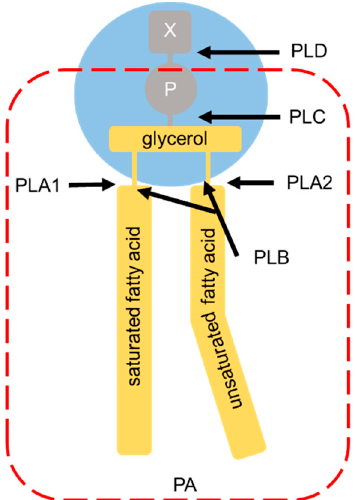
Figure 4. Phospholipase hydrolysis sites. Phospholipase classification is based on their specific sites of phospholipase-mediated hydrolysis. The head groups of the glycerophospholipids are bound to the glycerol moiety at the sn -3 position. X: choline (for phosphatidylcholine), ethanolamine (for phosphatidylethanolamine), serine (for phosphatidylserine), or myo-inositol (for phosphatidylinositol); P: phosphate group; PLD: phospholipase D; PLC: phospholipase C; PLA1: phospholipase A1; PLA2: phospholipase A2; PLB: phospholipase B. The arrows indicate the sites of hydrolysis by each phospholipase. The part surrounded by the red broken line corresponds to phosphatidic acid (PA). PLA2G6 ( iPLA2-VIA / iPLA2 β ) has been reported as the causative gene for an autosomal recessive form of PD ( PARK14 ), infantile neuroaxonal dystrophy (INAD), and neurodegeneration with brain